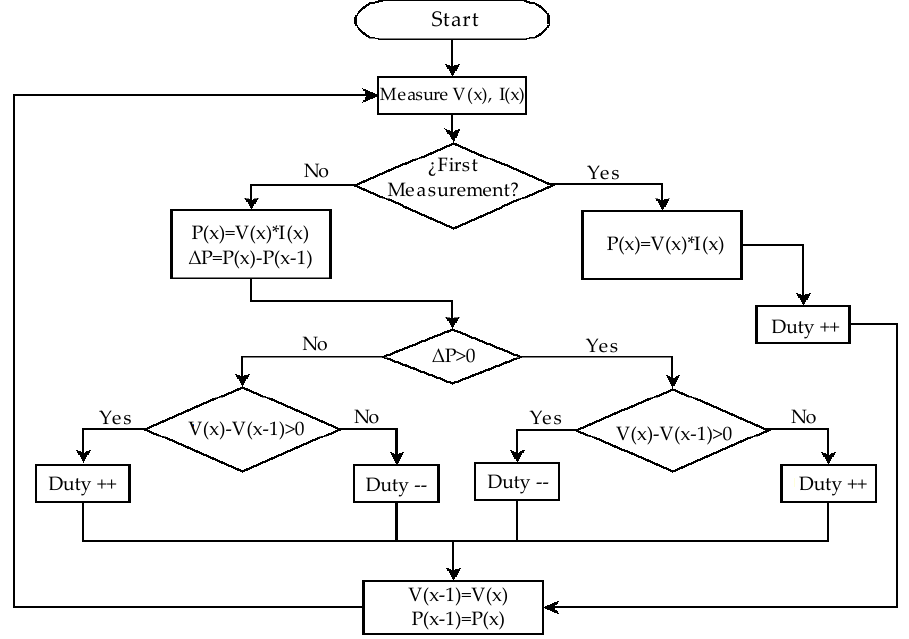
Figure 12. Flowchart of the perturbation and observation (P&O) controller.